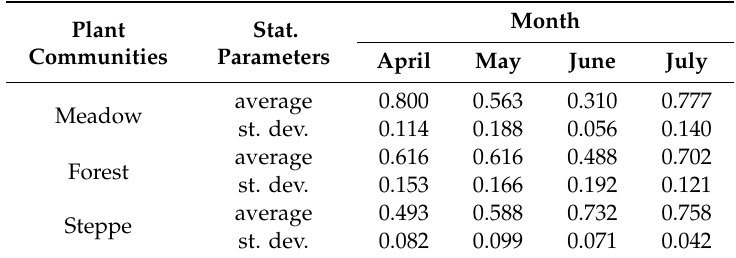
Table 4. Canonical correlation coe ffi cients for the study areas and long-term annual average canonical correlations for the forest, steppe, and meadow plant